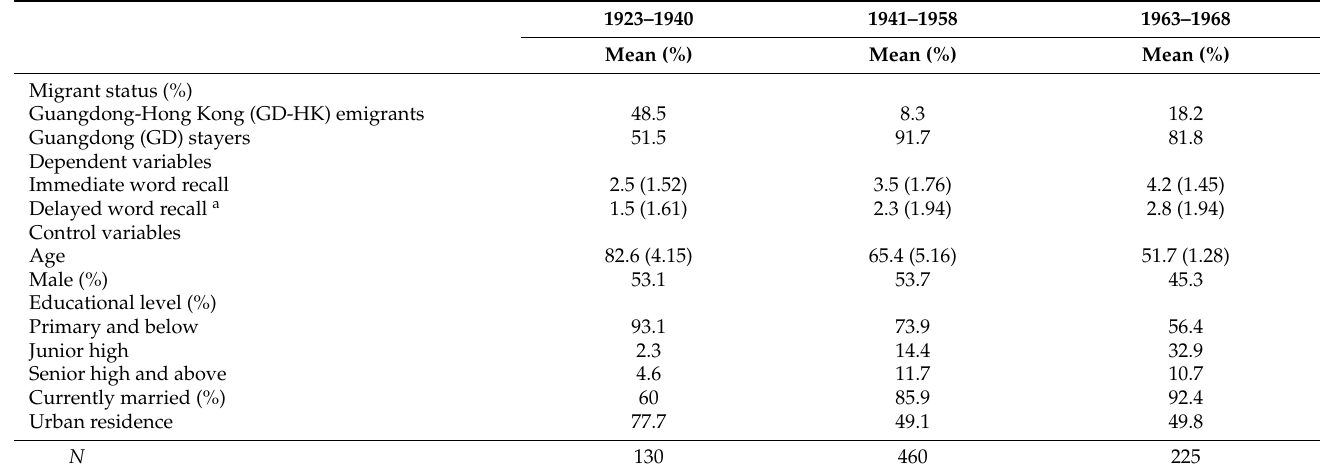
Table A2. Summary statistics for selected variables of the CFPS and HKPSSD combined sample (the migrant–stayer comparisons approach).